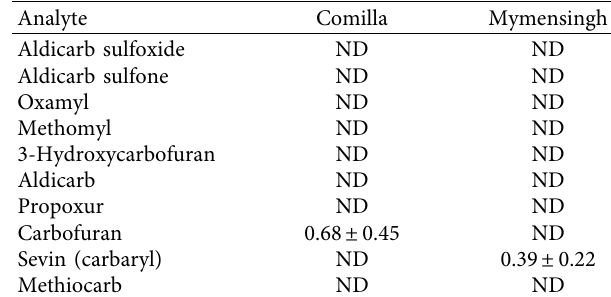
Table 4: Mean concentration ± SD ( μ g/L) of detected CBs analytes in water samples.